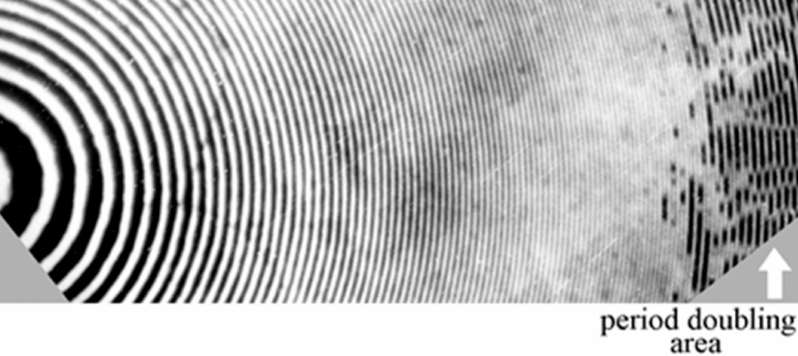
Figure 3. Microphotograph of holographic Fresnel Zone Plate, including the area with period